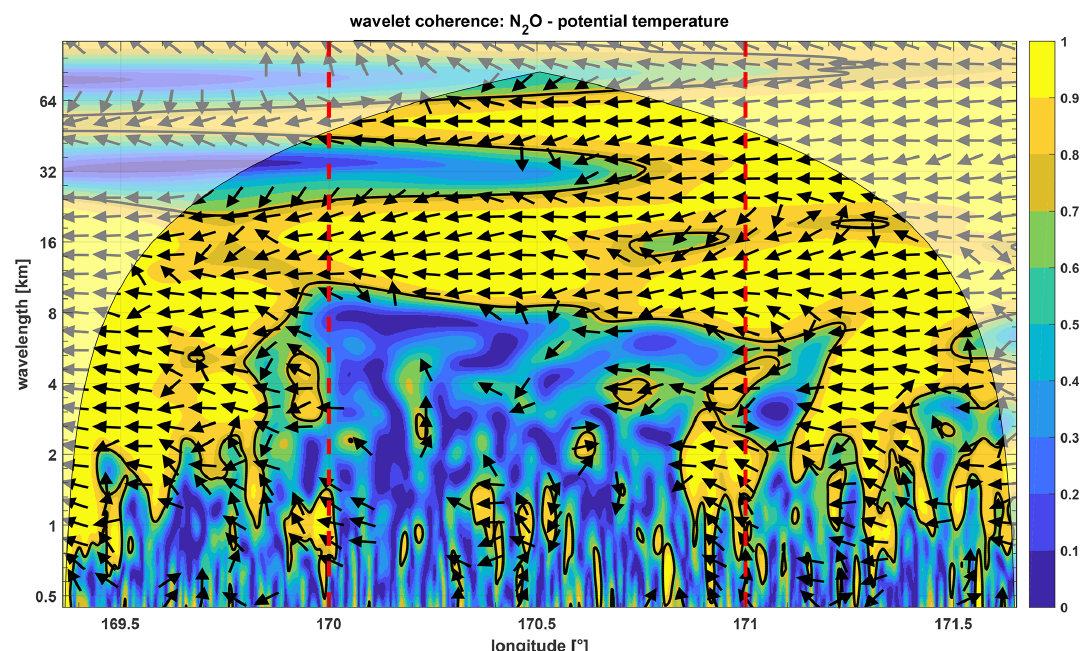
Figure 11. Wavelet coherence of N 2 O and potential temperature (wavelength = period · flight speed (216ms − 1 ), see Eq. 2). Arrows to the left indicate that N 2 O and potential temperature are shifted by 180 ◦ . In regions with a coherence lower than 0.5, the phase indication is removed. The shaded region marks the cone of influence, where edge effects affect the analysis. The solid lines show the 95% confidence level as given in Sect. 2.4. Yellow colors indicate a high coherence and blue colors indicate a low coherence. Vertical lines mark the upstream, above mountain, and downstream side.